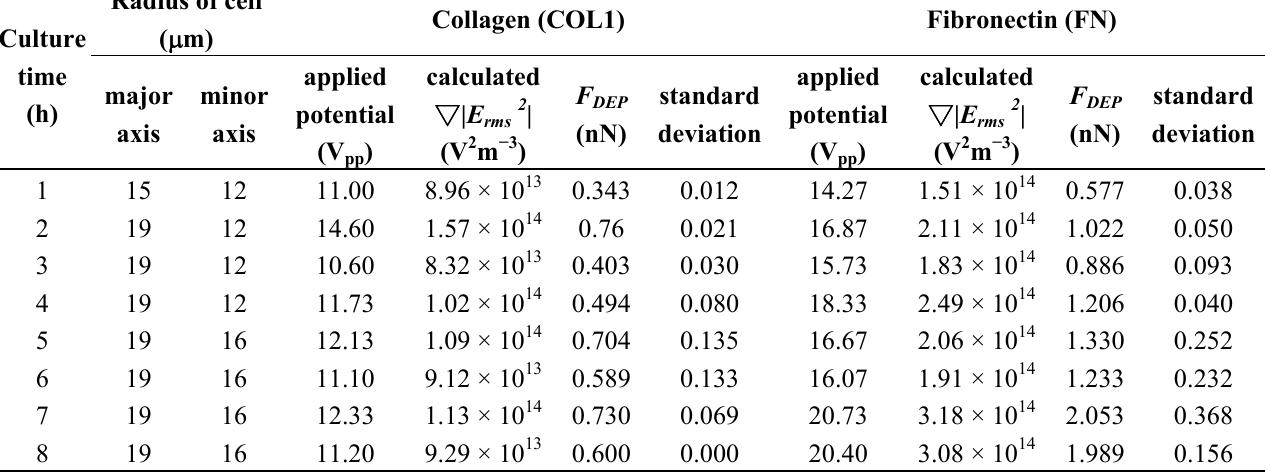
Table 1. The cell adhesion force (F ) of ECV304 cells cultured on COL1 and FN coated DEP PDMS membranes at varied cell culture time, based on the calculated value of ▽ E (cid:3045)(cid:3040)(cid:3046)(cid:2870) in the present